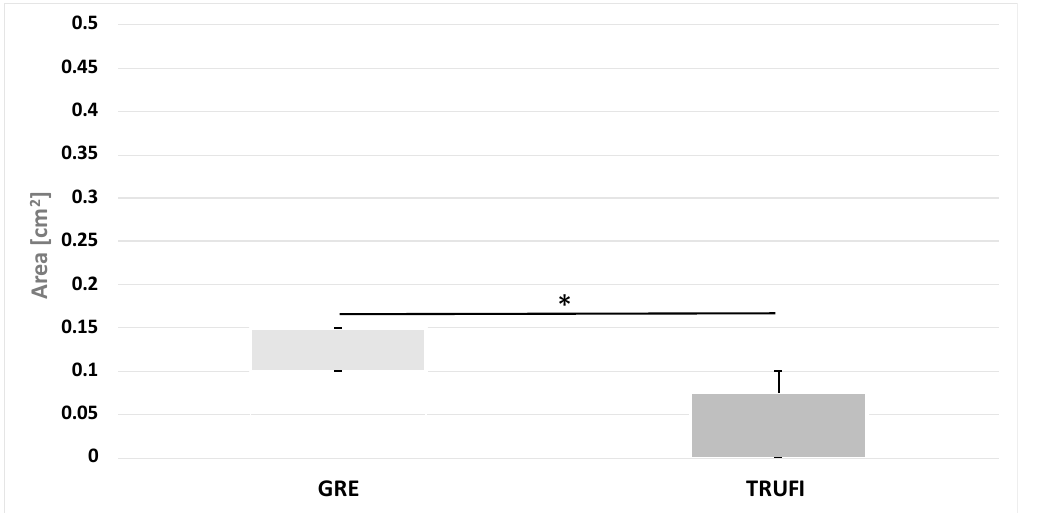
Figure 9. The values of the maximum area of the rima glottidis compartments on the side of the paralyzed vocal fold during phonation in MRI dynamic sequences. * p = 0.0119.